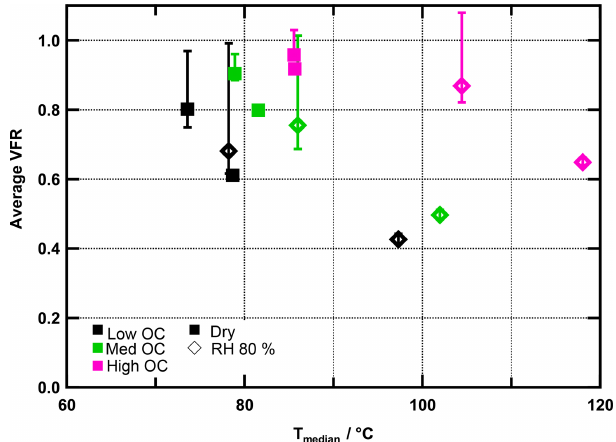
Figure 2. Average VFR during FIGAERO sampling vs. median des- orption temperature ( T median ) for all experiments. Colours indicate O : C ratios. Measurements under dry conditions are marked with squares, those under RH80% with diamonds. Error bars indicate minimum and maximum VFR observed during sampling